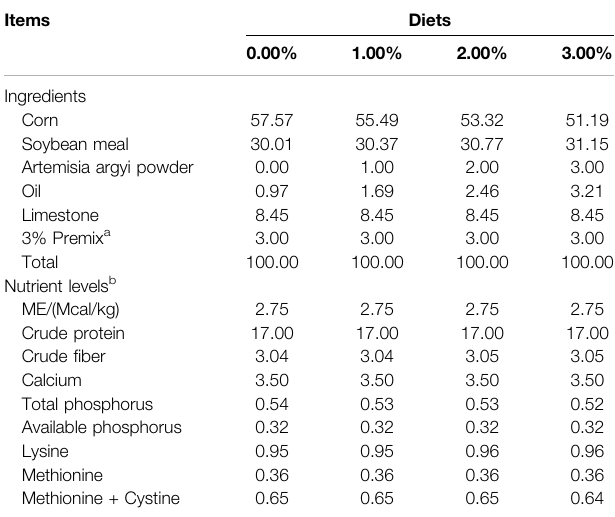
TABLE 1 | Composition and nutrient levels of basal diets (air-dry basis, %).